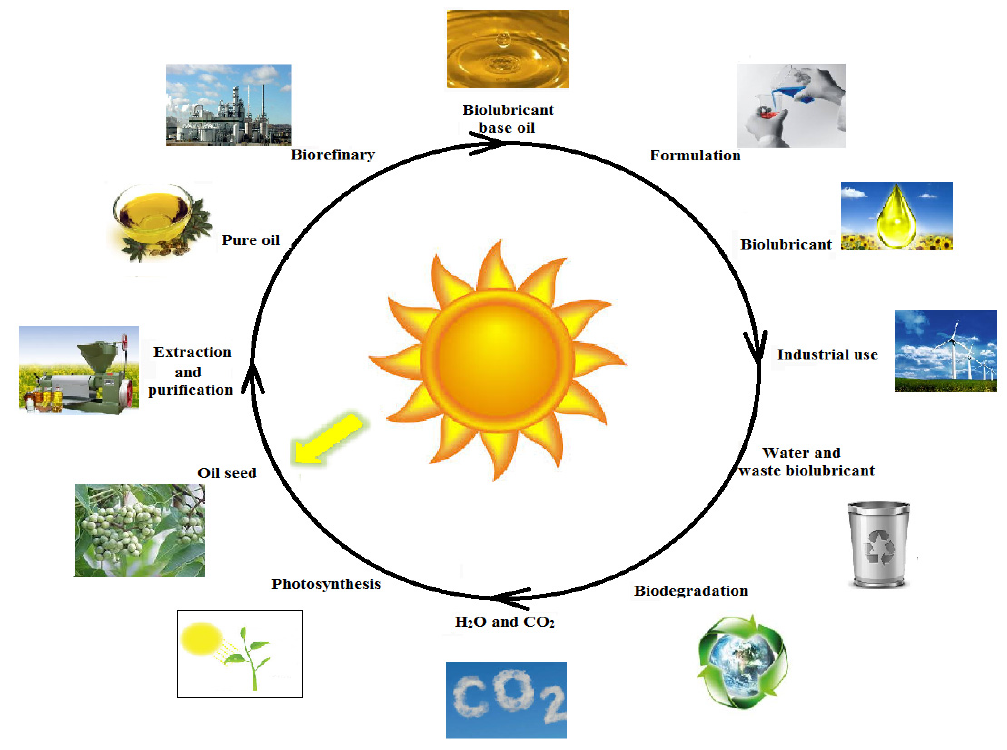
Figure 1. Biolubricants LCA.